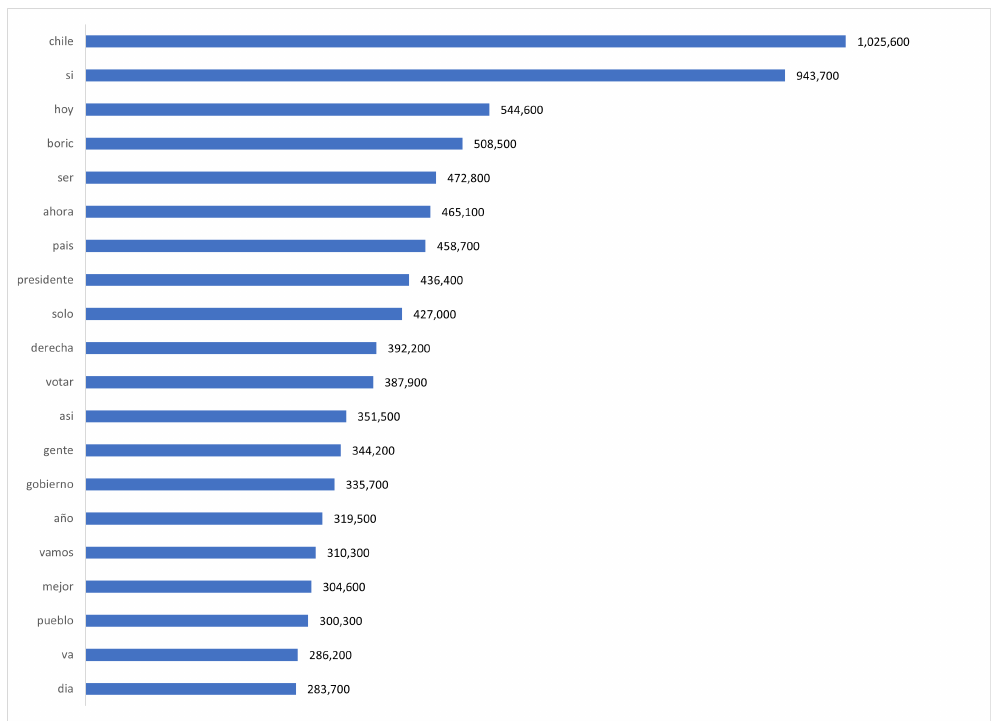
Figure 7. Top 20 popular words during the period January 2021–March 2022.